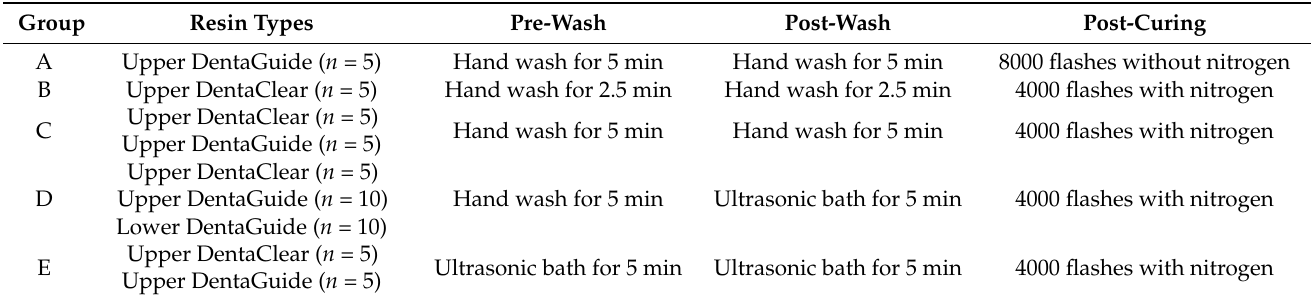
Table 2. Breakdown of specific post-processing techniques used for resin and arch type per